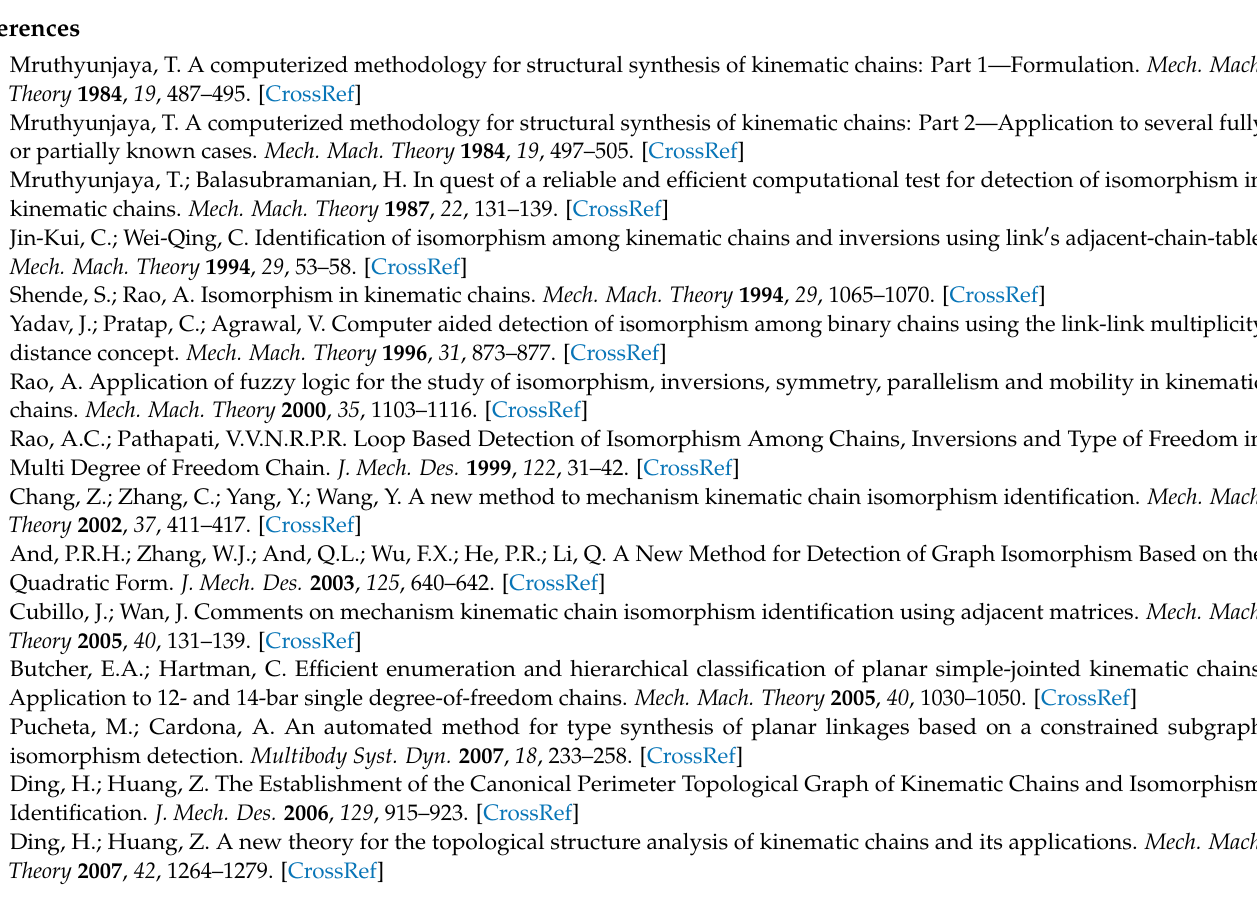
Figure A8. Unified Joint matrix, UJM, for all planar 10 links and 1-dof KCs with simple joints [41].